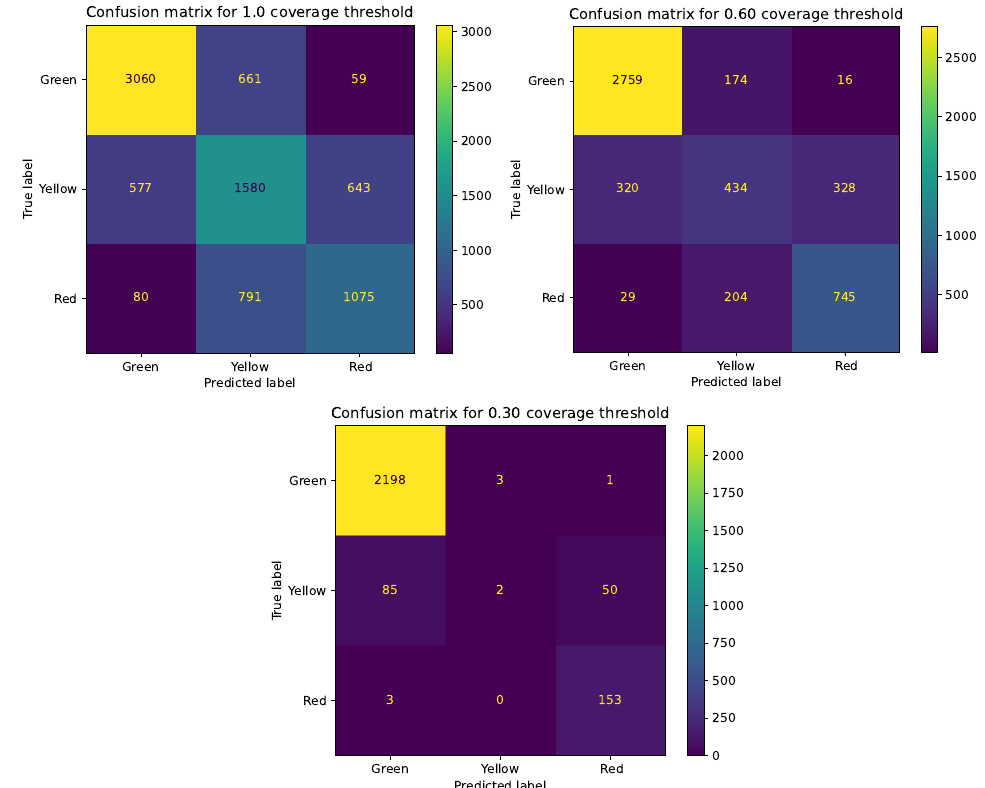
Figure 6. Confusion matrix obtained for different coverage thresholds: full dataset coverage and a baseline value for the critical error rate ( top left ), 60% coverage ( top right ), and 30% cover- age ( bottom